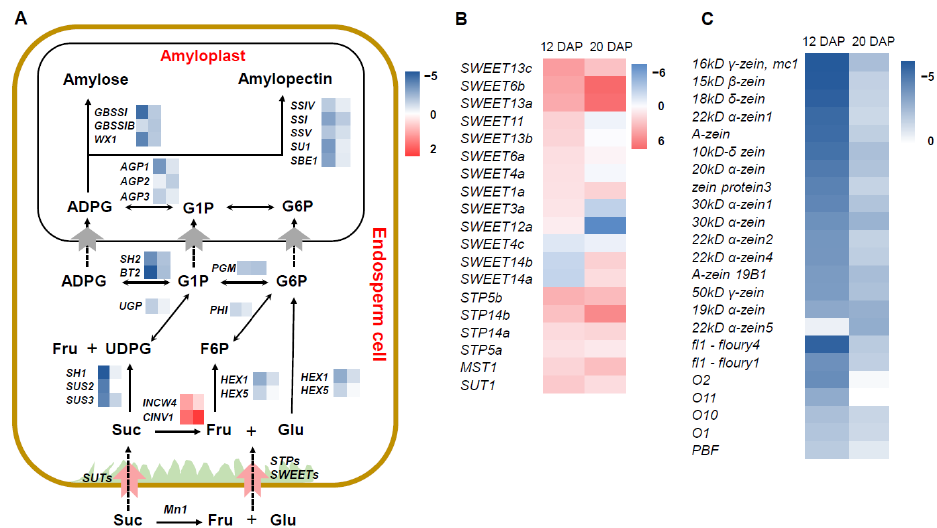
Figure 5. Heat maps of the DEGs that participate in the selected disrupted function or pathway. ( A ) Heat maps of DEGs enriched in starch and sucrose metabolism. The left side color bar represents 12 DAP, the right side color bar represents 20 DAP. ( B ) Heat maps of DEGs with the sugar transport function. ( C ) Heat maps of DEGs with IAA synthesis and signaling functions. The color bar indicates the log2 (fold change) values from small to large.